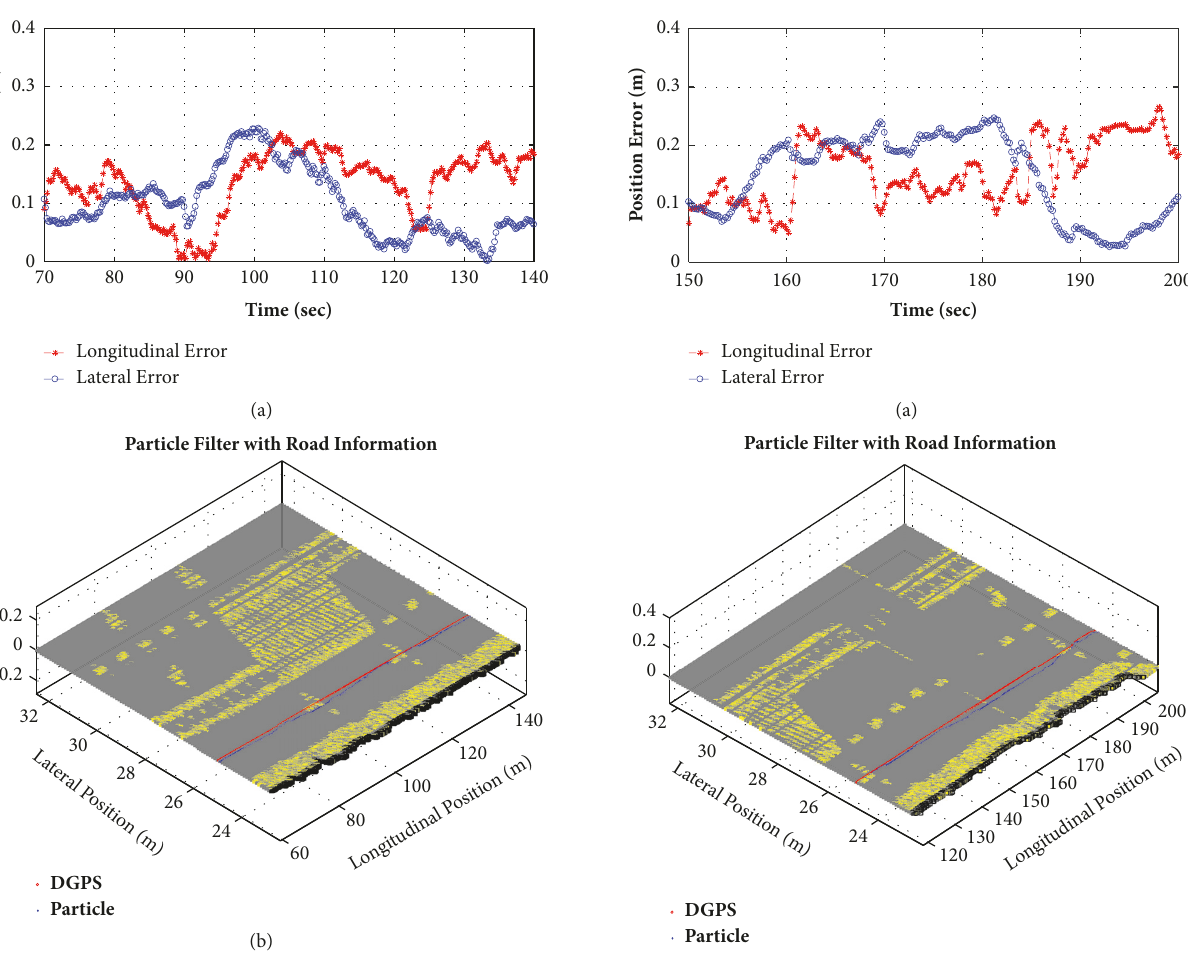
Figure 12: Particle filter localization at the second section (between 70 s and 140 s): (a) the position error and (b) the comparison of the trajectory obtained by the particle filter and the DGPS.